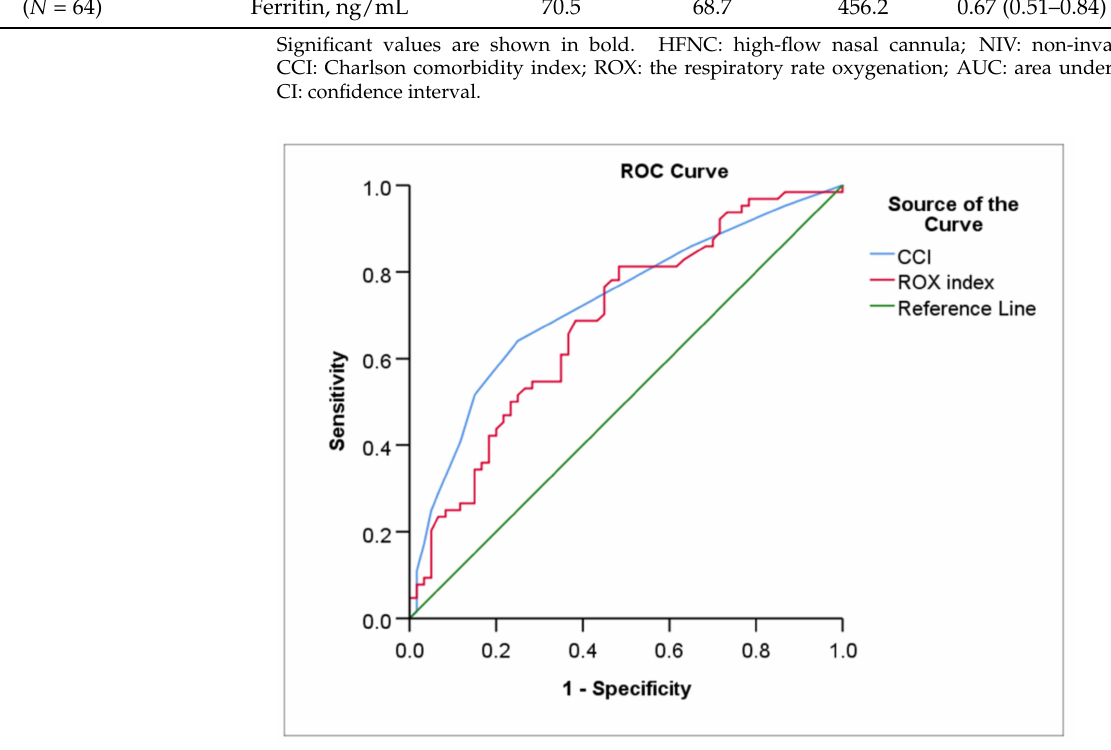
Figure 2. The ROC curves of the CCI and ROX index at 24 h for predicting HFNC failure. HFNC: high-flow nasal cannula; CCI: Charlson comorbidity index; ROX: the respiratory rate oxygenation; ROC: Receiver operator